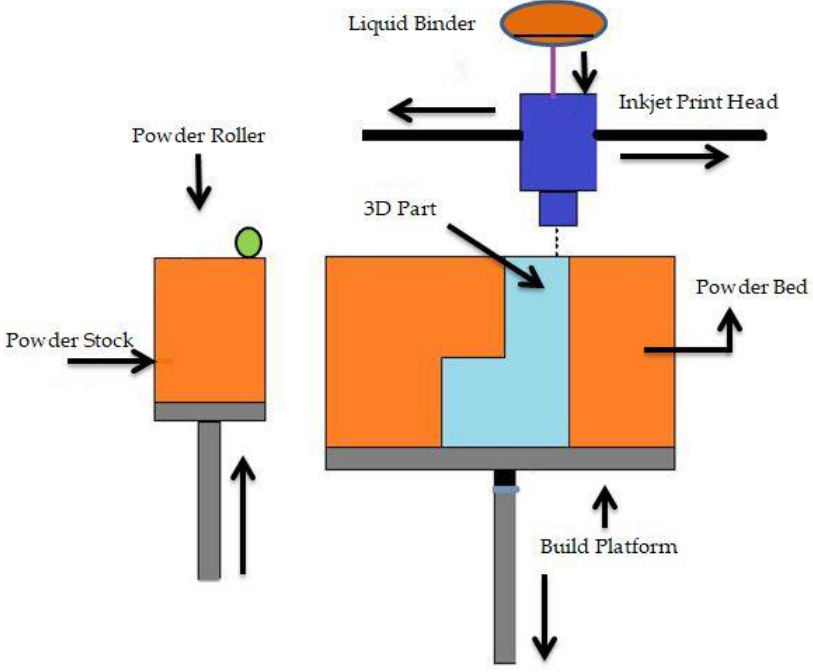
Figure 5. Schematic representation of binder jetting.